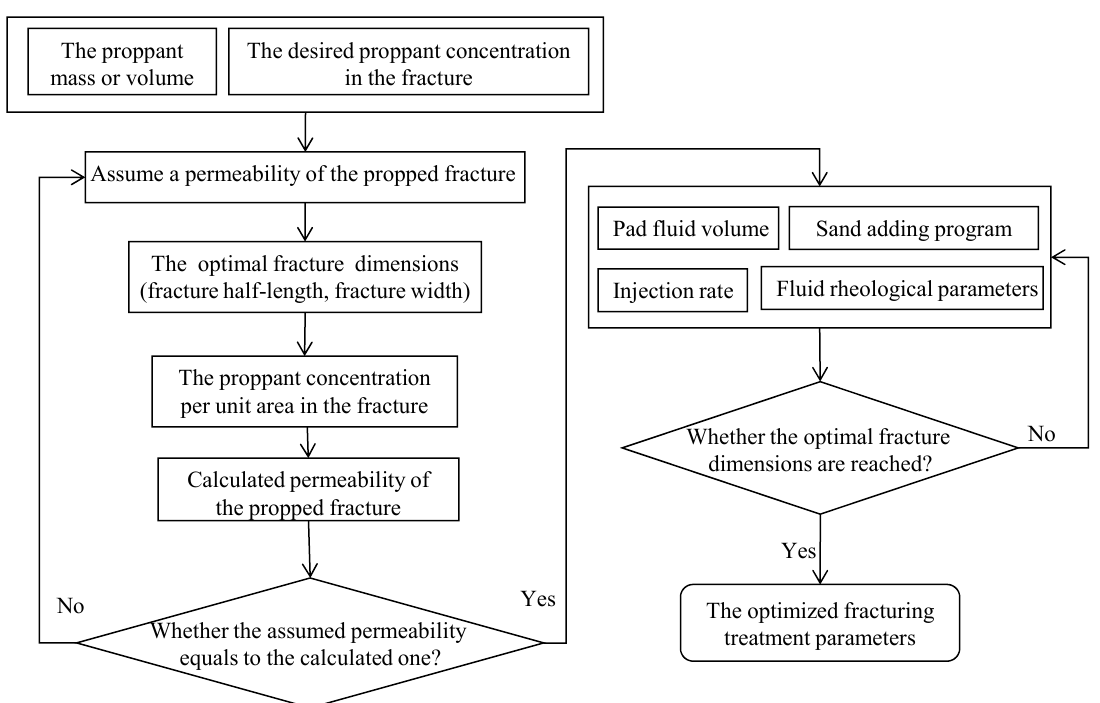
Figure 3. Flowchart of the proposed optimization method.